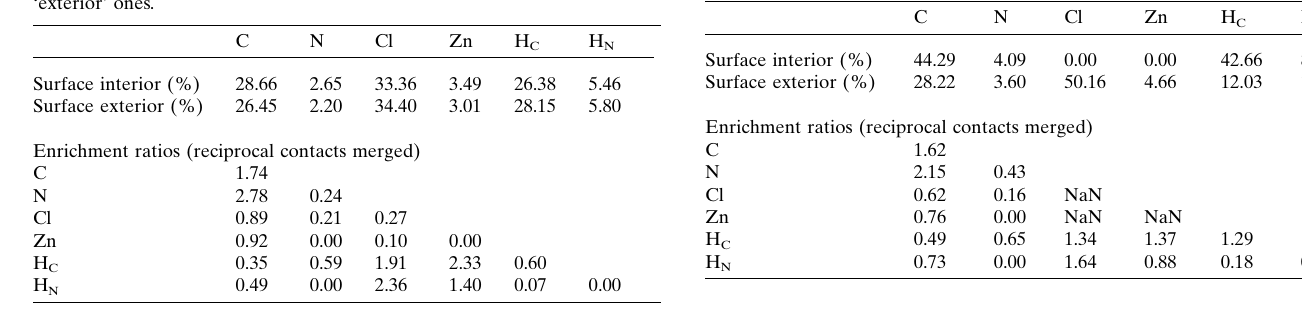
Table 5 Hirshfeld contact surfaces and ERs for 44TP. The first column corresponds to ‘interior’ atoms and the remaining columns to ‘exterior’ ones.